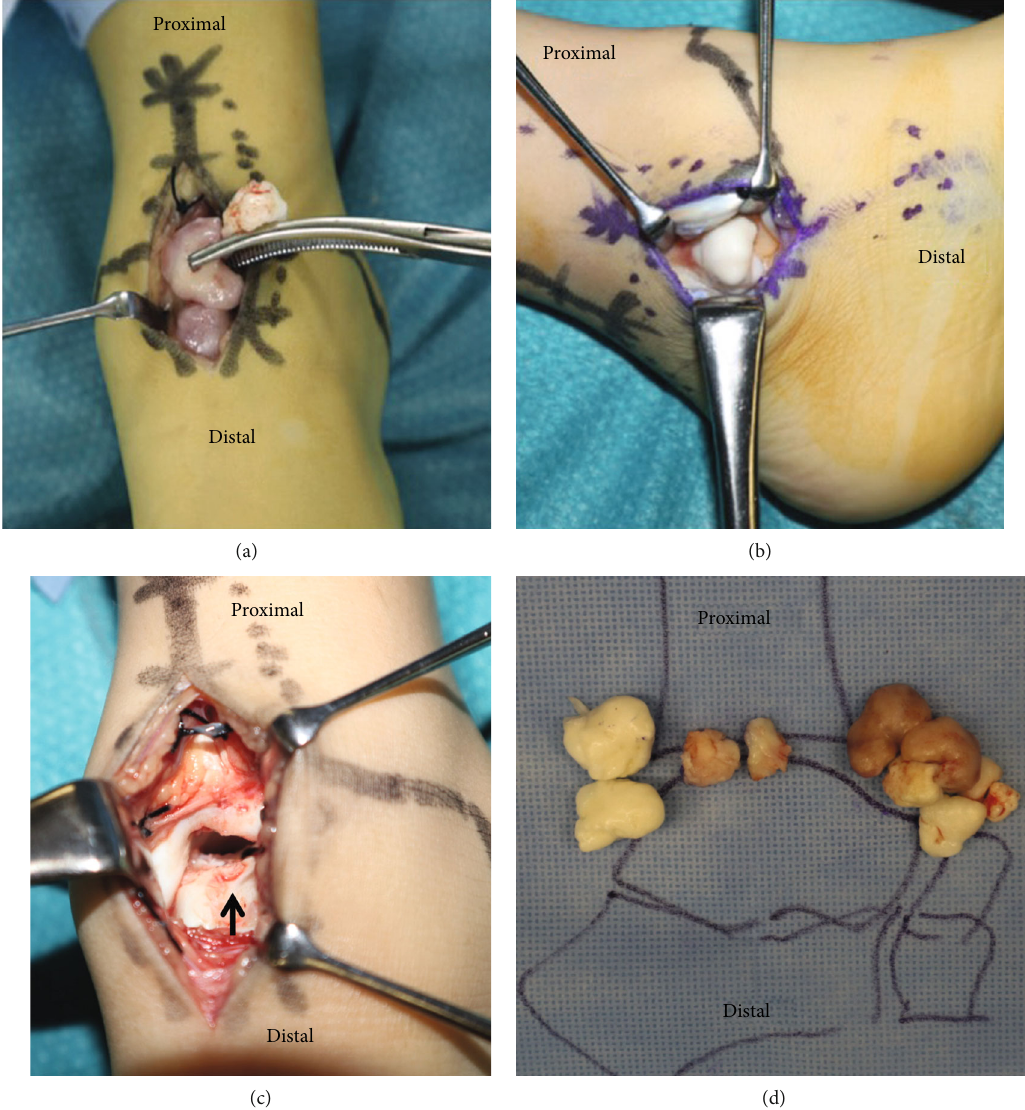
Figure 3: Intraoperative picture: (a) anterior midline incision, (b) posteromedial incision, (c) talar dome, and (d) removed intra-articular free bodies. Excisions of the protuberances from the talus rendered a circular articular cartilage defect (black